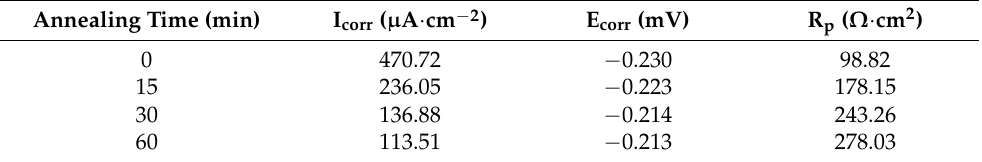
Figure 4. Polarization curves of CoCrNiSi 0.3 MEA with CrN films deposited for different sputtering times, tested in a 1 M H 2 SO 4 solution. Table 2. The corrosion current density (I corr ), polarization corrosion potential (E corr ) and polarization impedance (R p ) of CoCrNiSi 0.3 MEAs with various annealing time tested in a 1 M H 2 SO 4 solution.